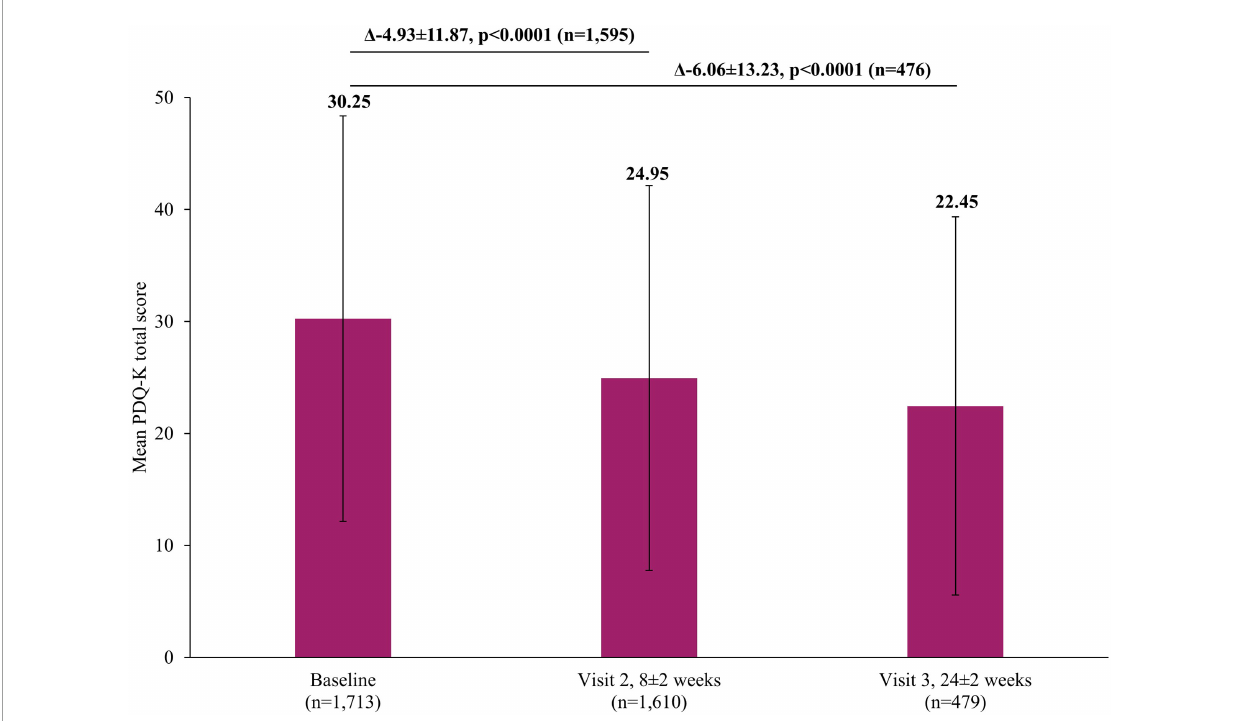
FIGURE5 Change in PDQ-K total score from baseline. The mean PDQ-K total score at Visit 1 was based on all patients, not just those that also had data at Visit 2 or Visit 3, however, when analyzing the difference between the visits (Visit 1 to Visit 2 and Visit 1 to Visit 3), scores of patients who had scores at both visits were included. Therefore paired t -test assessed the difference at Visit 2 (8 ± 2 week) versus Visit 1 (0 week) in 1,595 patients and difference at Visit 3 (24 ± 2 week) versus Visit 1 (0 week) in 476 patients. Error bars represent standard deviations. PDQ-K, Korean version of Perceived Deficits